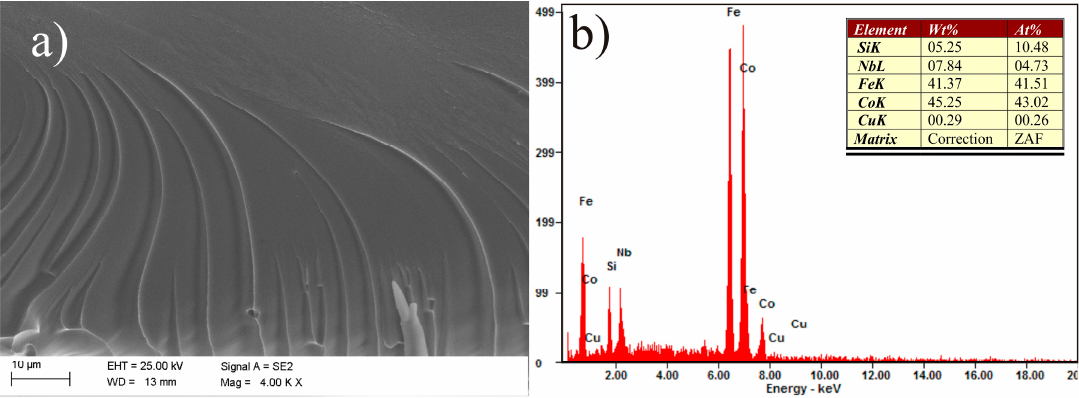
Figure 6. SEM micrographs of the fracture morphology of Fe 35.75 Co 35.75 B 18.90 Si 5 Nb 4 Cu 0.6 ribbon with the thickness of 0.07 mm: ( a ) view; ( b ) EDS spectrum from area in (a).